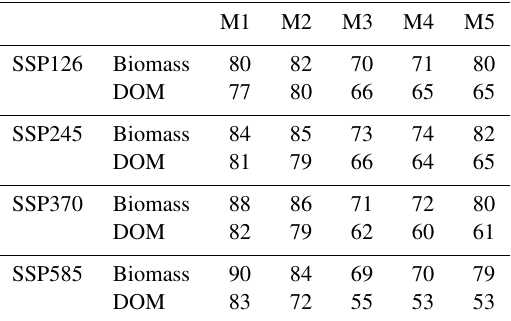
Table A6. Climate-change-scenario-specific estimates of the likeli- hood of biomass and DOM increasing (2001–2100) per DALEC model. Likelihoods are presented as a percentage to the